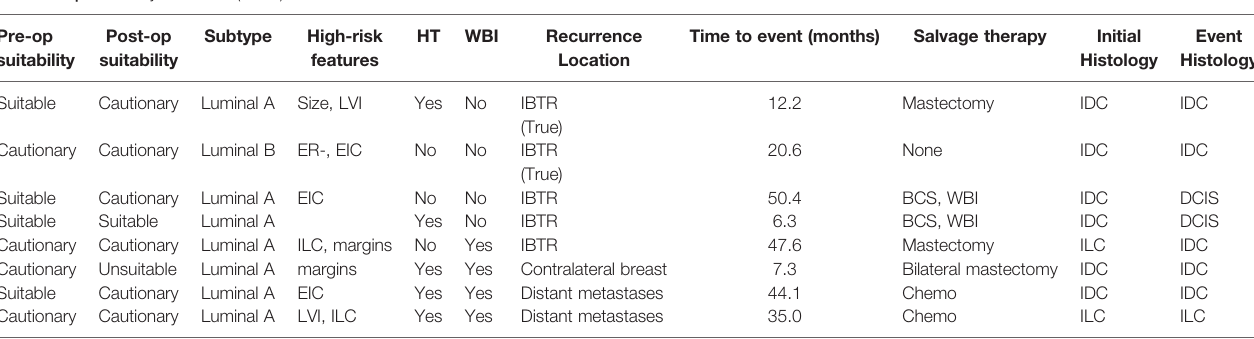
TABLE 5 | Summary of events (n = 8).